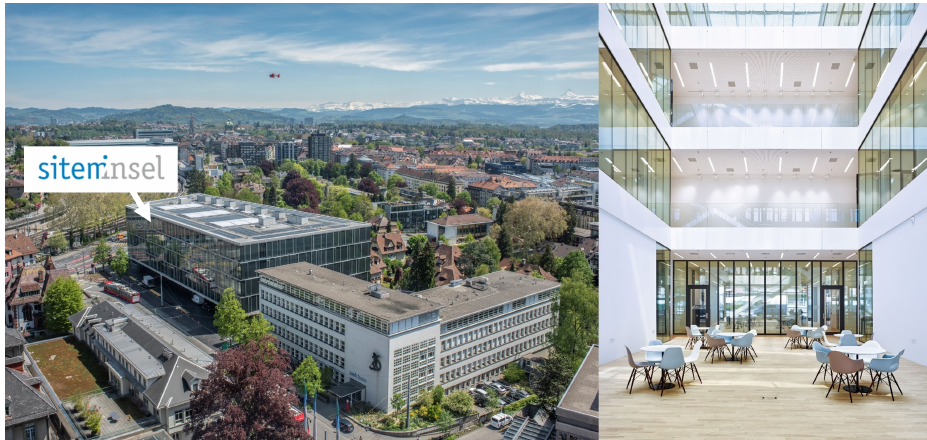
Figure 1. NeuroTec is located at the new Swiss Institute for Translational and Entrepreneurial Medicine (sitem) on the campus of Inselspital, the University Hospital of